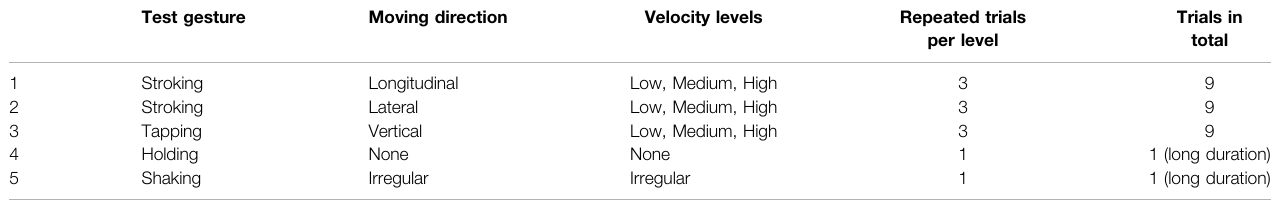
TABLE 2 | Experiment procedure for validating contact velocity.